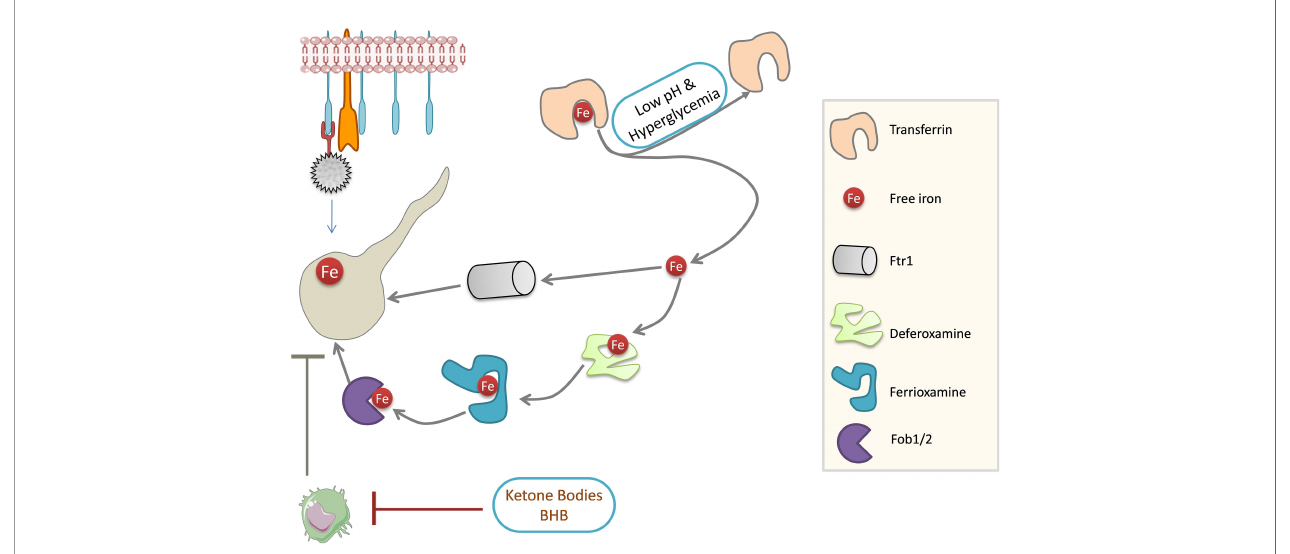
FIGURE 4 | Mucorales iron metabolism. Iron is required for Mucorale growth. Fungi can obtain iron through permease Ftr1 and Fob1/2 system. Strong iron af fi nity molecules can obtain iron from the iron chelator, deferoxamine, which is ultimately acquired by fungi for growth. Iron-binding activity of transferrin is impaired in DKA patients: low pH dissociates iron from transferrin and high glucose concentrations can glycosylate transferrin, resulting in the release of free iron. Ketone bodies impair phagocytosis and dampen the immune response in DKA patients. Ftr1: high-af fi nity iron permease 1 (Fe TRansporter); Fob1/2, ferrioxamine binding (Fob)